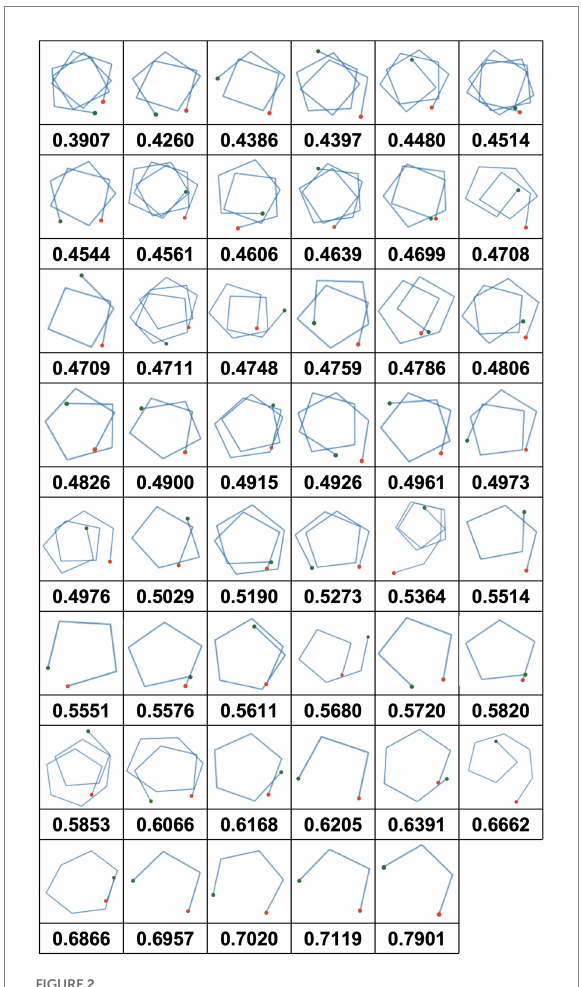
FIGURE 2 Individual plots of semantic relatedness values for each participant. Plots are provided in ascending order according to semantic relatedness values. The red dot in each plot represents the starting point, and the green dot represents the end point.